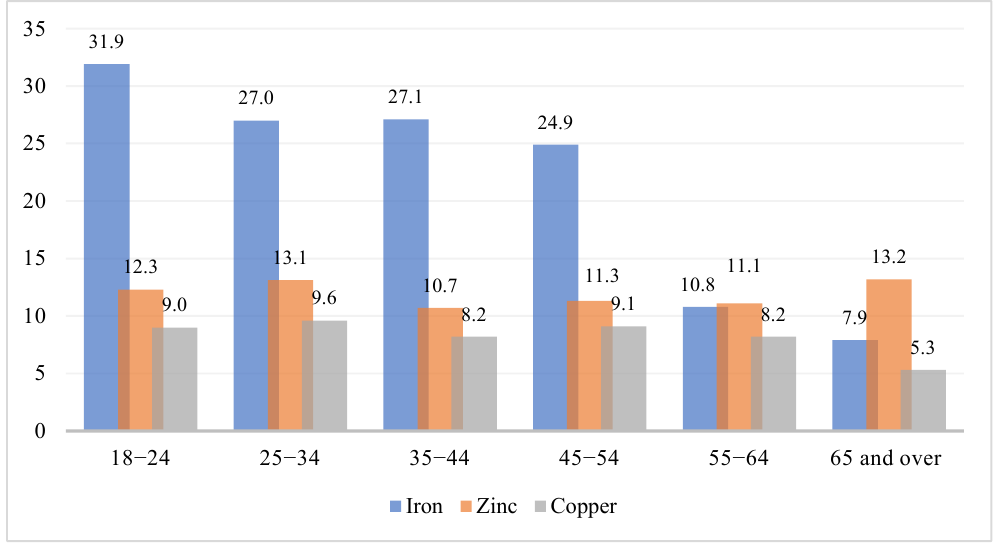
Figure 2. Prevalence of iron, zinc, and copper deficiencies based on age